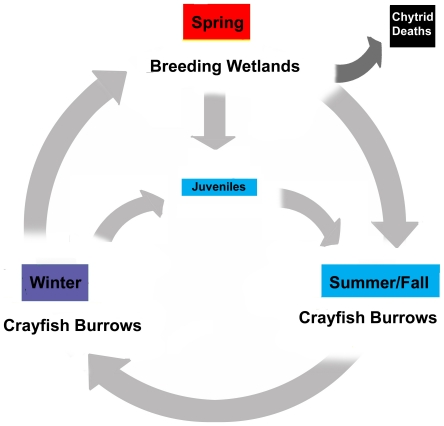
A simple model showing the patterns of Bd gain and loss in Crawfish Frogs based on our data.Red box indicates highest rate of Bd infection, blue box indicates cleared or low-level infection, purple box indicates intermediate level infection. Note that following breeding, infected frogs lose the disease during the summer when their activity is centered at the burrow entrance. During the winter, frogs inhabit the water at the base of the burrow, where a subset of animals re-acquire the disease. These infected animals then transmit Bd to their breeding wetland during relatively short (from a few hours to several days) migrations. In breeding wetlands, a subset of animals acquire Bd and a subset shed the disease, but most Crawfish Frogs maintain their status (Bd positive or negative). Some animals exiting wetlands develop chytridiomycosis and die. Exiting juvenile Crawfish Frogs were generally Bd negative (1% infection rate). Juveniles may be exposed to Bd while overwintering during the ≥two years (males) or ≥three years (females) prior to their first breeding attempts, or they may become exposed during their first breeding attempts. Once young Crawfish Frogs begin breeding, they follow the model outlined for breeding adults.